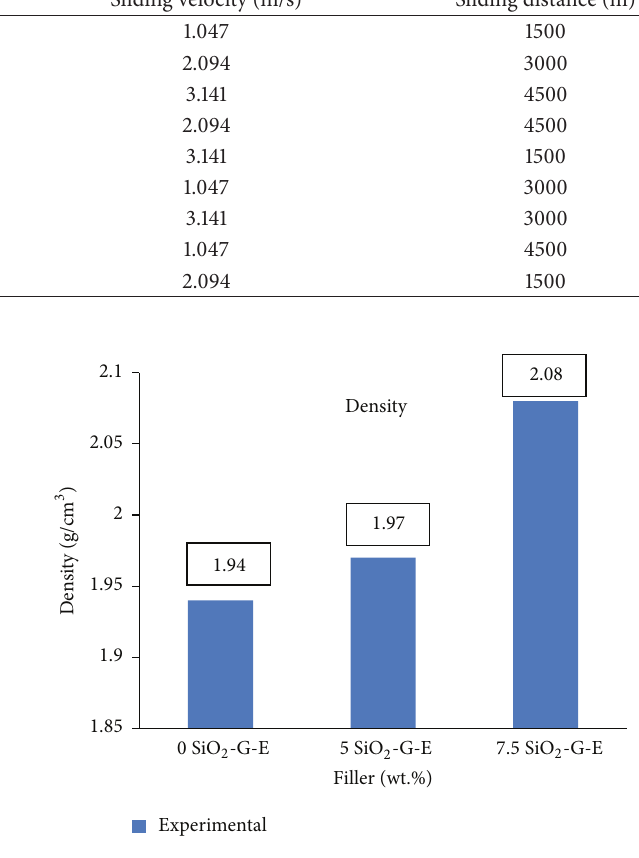
Figure 2: Density of SiO 2 filled G-E